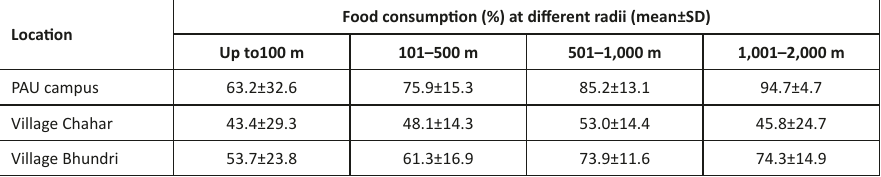
Table 4. Food consumption by rodents around roosting and nesting sites of Spotted Owlets.